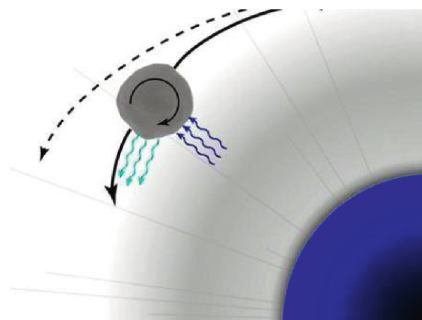
Figure 3: Basic reflection form of light.